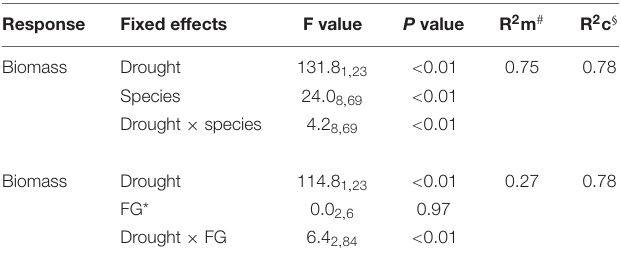
TABLE 2 | Linear mixed effects model output for the effects of drought on aboveground productivity of nine pasture and rangeland species during the 6-month winter/spring